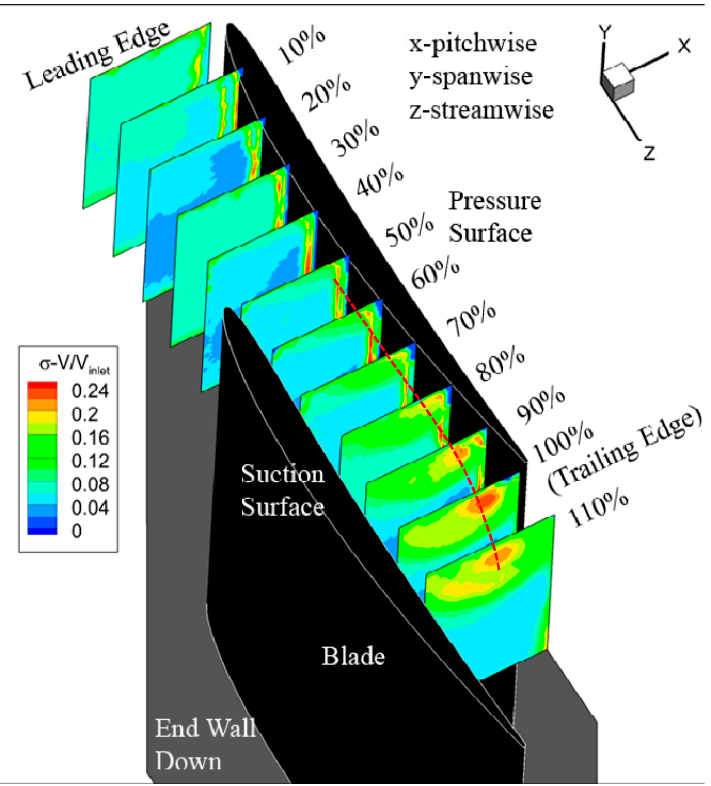
Figure 11. Standard deviation of normalized SPIV measured velocity in the blade passage. The velocity is the resultant velocity of components in the x-, y- and z-